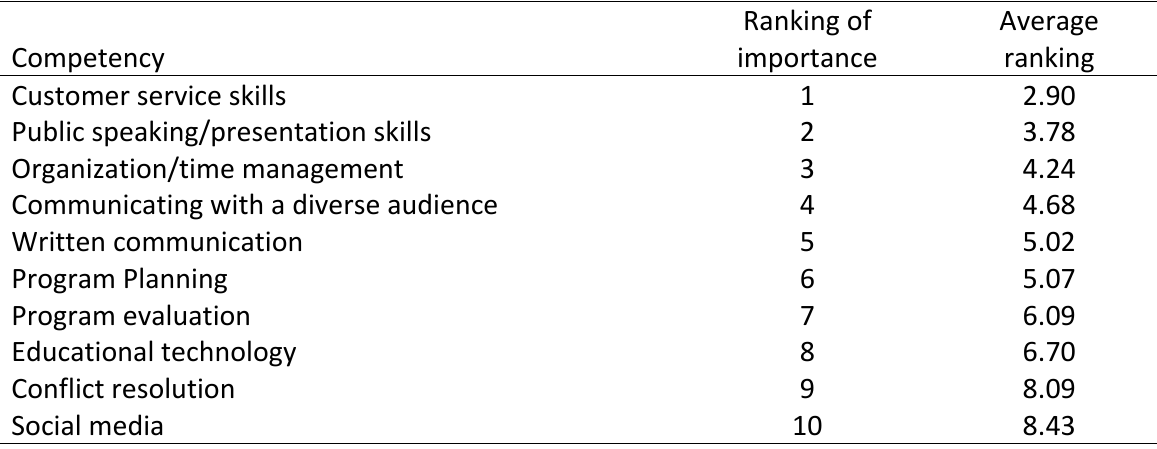
Ranking of Important Competencies from the Extension-Related Domain